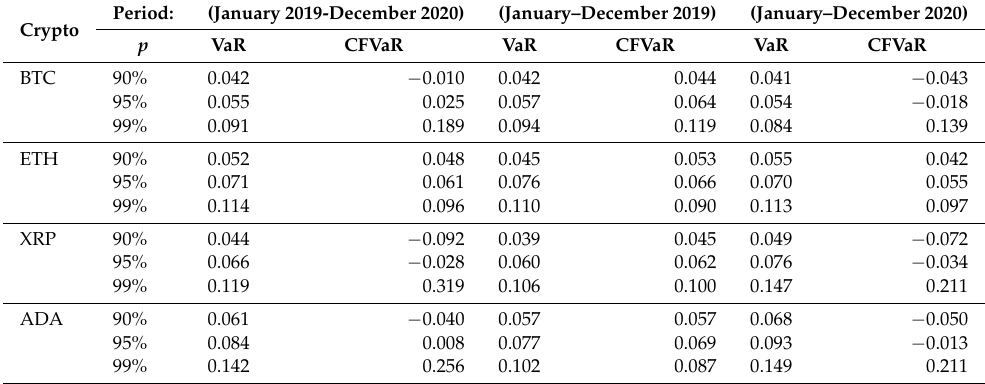
Table 8. Value at Risk (VaR) and Cornish–Fisher expansion (CFVaR) estimations—Cryptocurrencies.